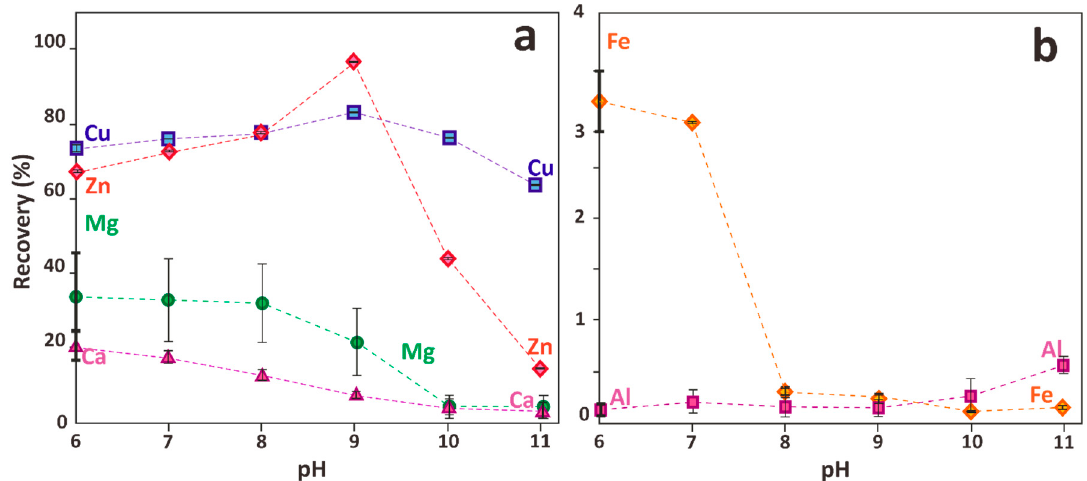
Figure 4. The recovery of ( a ) Zn, Cu, Mg and Ca and ( b ) Fe and Al as function of pH.